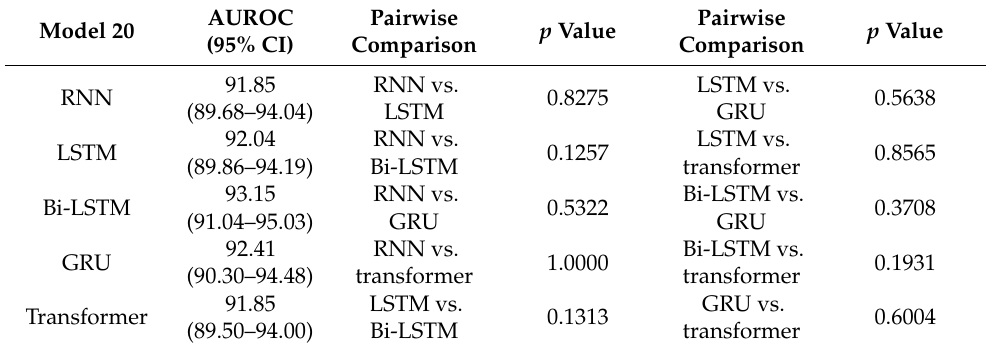
Table 3. Pairwise comparison of AUROC of Model 20 between 5